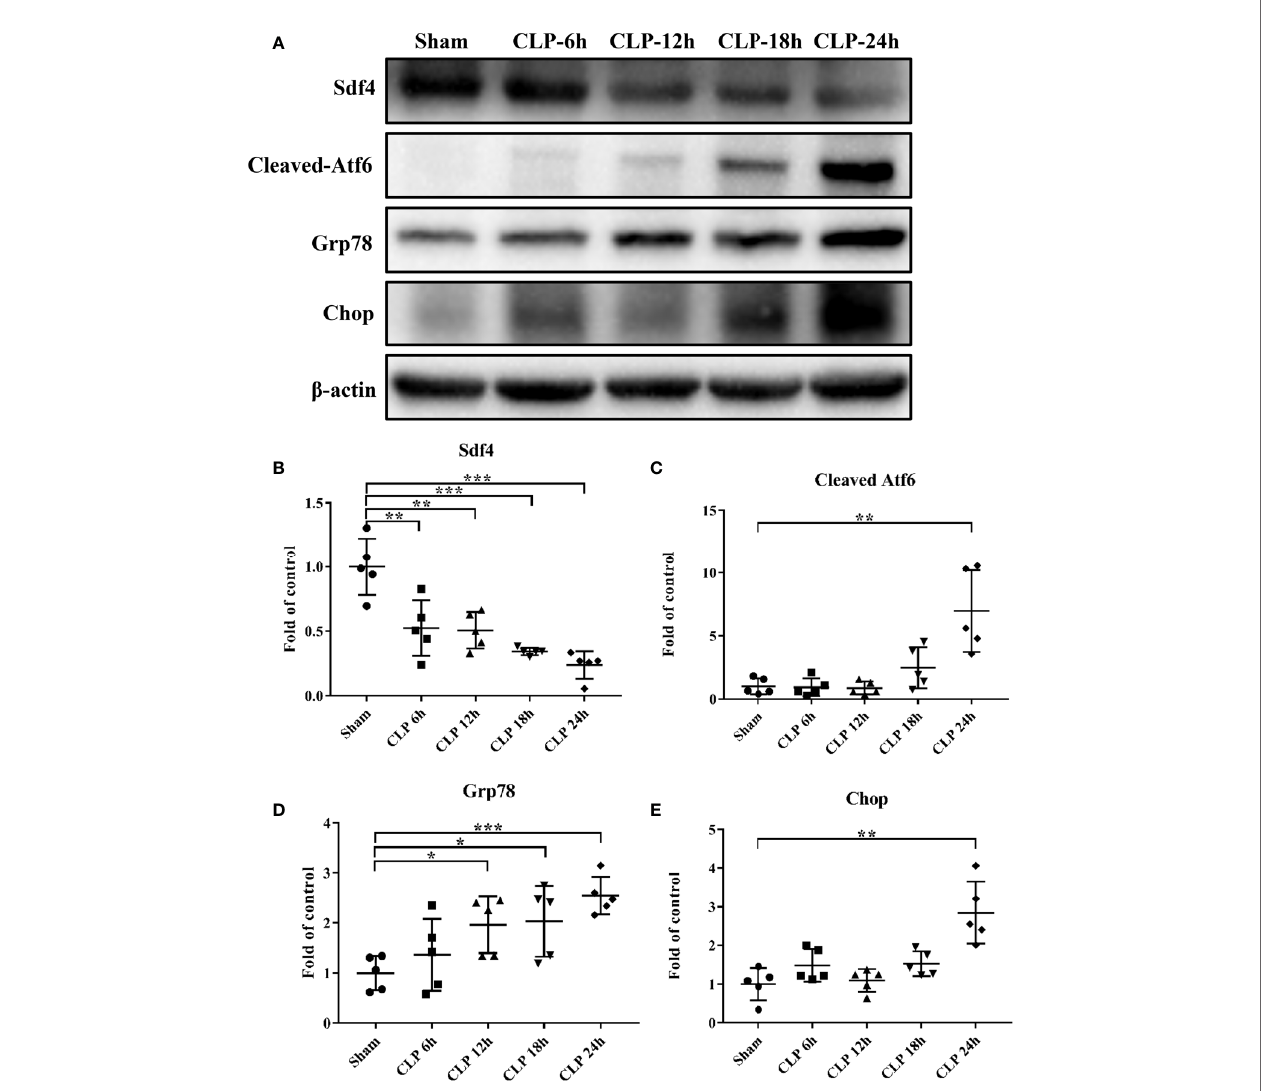
FIGURE 6 | (A) . Representative western blot results from sham-operated and CLP mice lung for levels of cleaved- Atf6 , Grp78 , Chop , and b -actin. (B – E) The cleaved- Atf6 , Grp78 and Chop bands were quanti fi ed by densitometry and normalized to the density of b -actin. n=5. Data were shown in Mean ± SD. ***p < 0.001, **p < 0.01, *p <